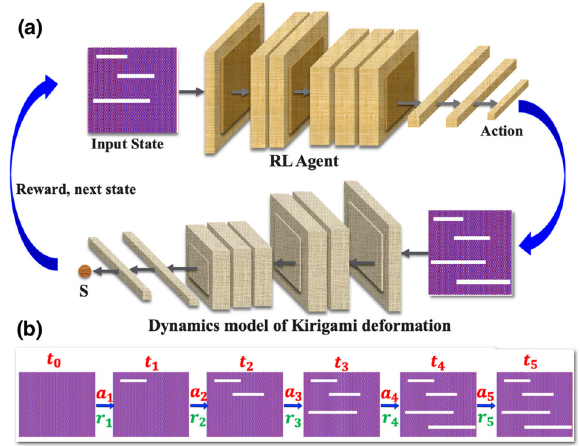
Fig. 2 RL agent for kirigami design. a A schematic of the RL agent and a dynamic model for the synthesis of MoS 2 kirigami structures. The dynamic model predicts the stretchability (S) of kirigami structure proposed by the RL agent and gives a reward to the RL agent which is used by agent to update its policy so as to maximize its total reward and creates structures with high S. b An episode of RL agent showing initial, fi nal and intermediate structures and the associated actions taken and rewards received during the synthesis of MoS 2 kirigami